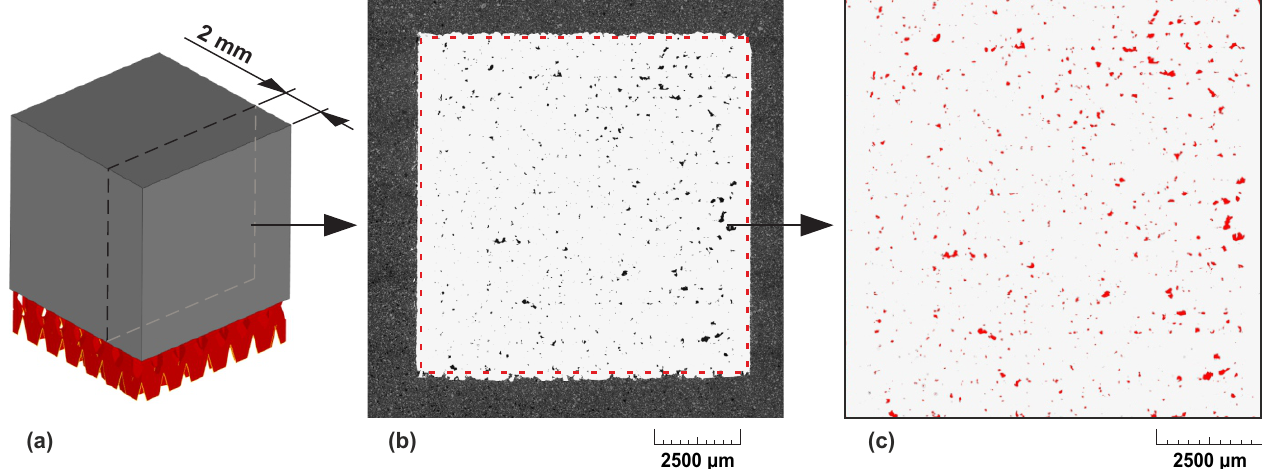
Figure 7. Porosity evaluation process ( a ) Cut section for porosity evaluation ( b ) Picture of the whole specimen cross-section ( c ) Image analysis with pores highlighted in red.